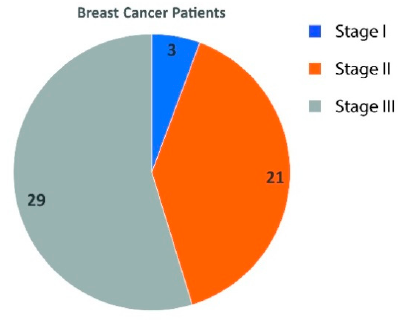
Figure 1. Distribution of breast cancer patients with stage I, II and III disease.